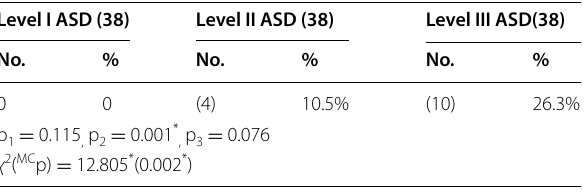
Table 8 The percentage of children having multiple chronic symptoms in the three groups who submitted to lab investigation